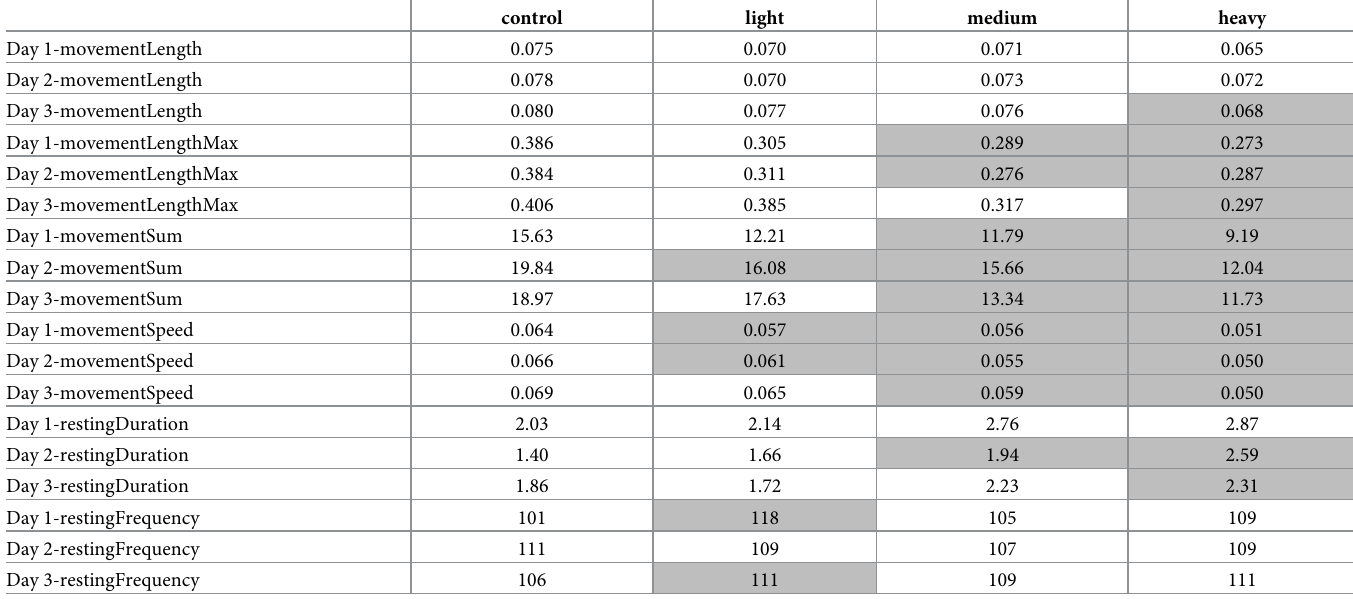
Table 4. Medians of movement properties of control crickets and crickets carrying light, medium, or heavy tags without regard to temperature. Gray highlighted val- ues indicate significant Mann-Whitney tests ( p < 0.05) for comparisons of movement properties of crickets with and without